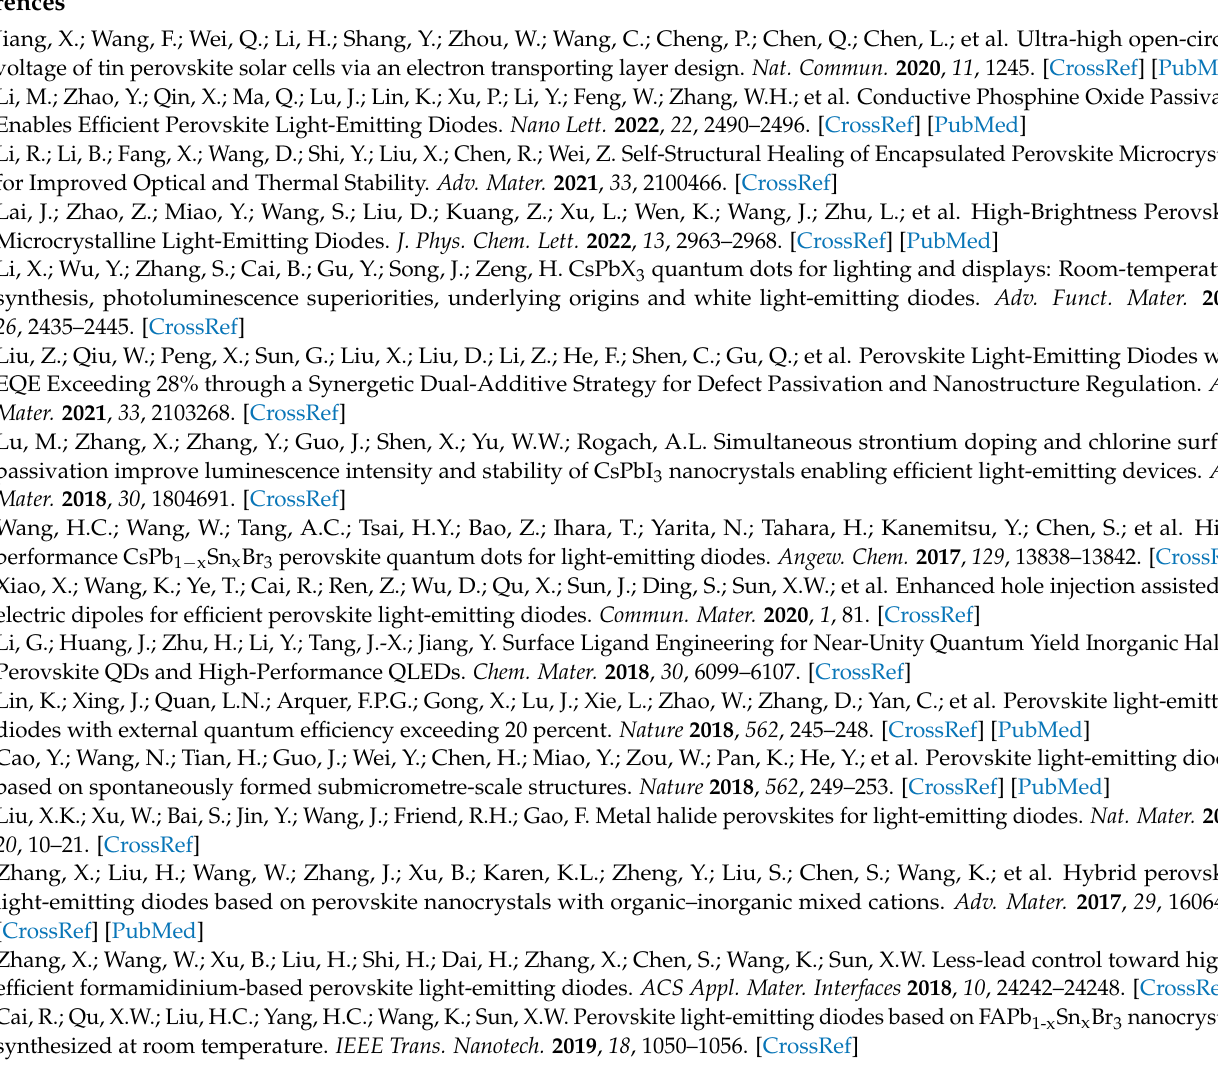
(c) PLQY statistics of as-prepared nanocrystals synthesized in different batches; Table S1: